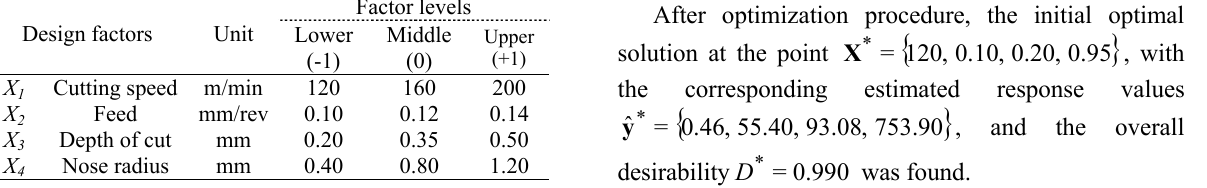
Table 14. Factors and their levels Design factors